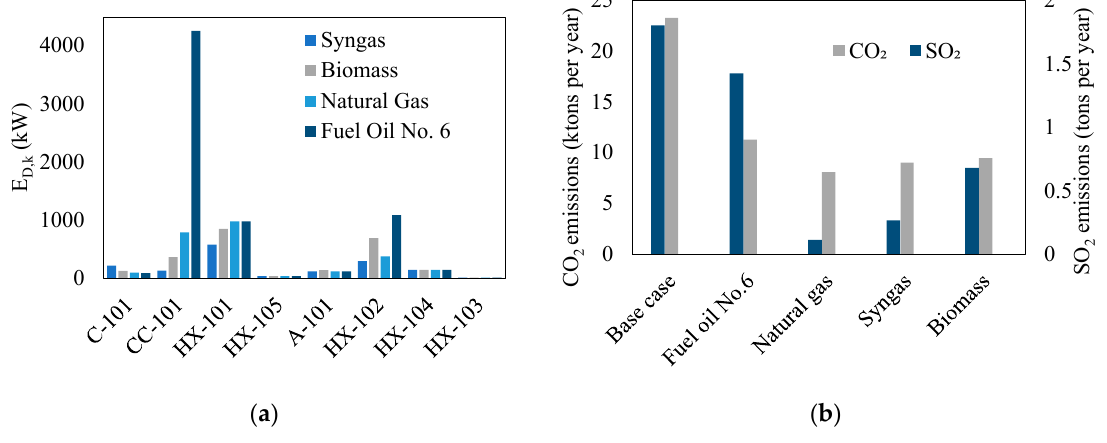
Figure 4. Comparison of ( a ) exergy destruction rate at a level component and ( b ) CO 2 and SO 2 emissions from the CCHP system based on different fuels.